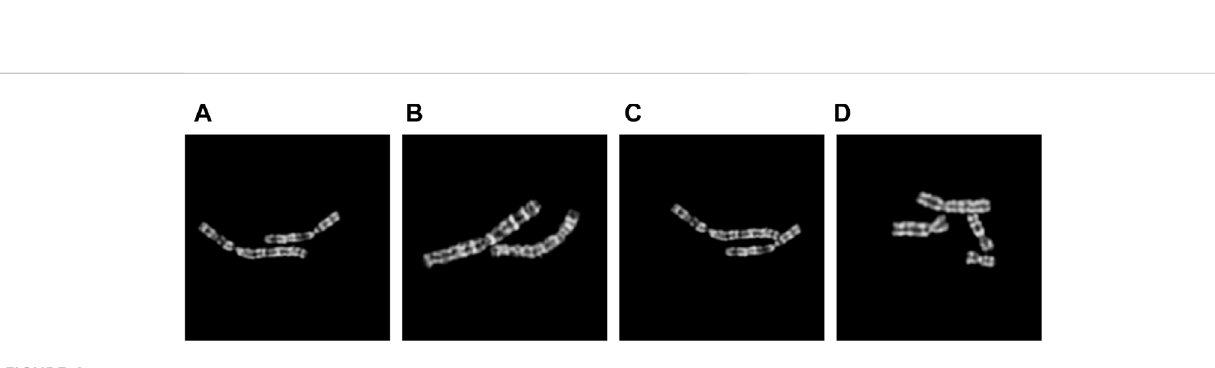
FIGURE 4 Examples of composed images with different number N of overlapping pixels. (A) N = 3; (B) N = 30; (C) N = 84; (D) N =